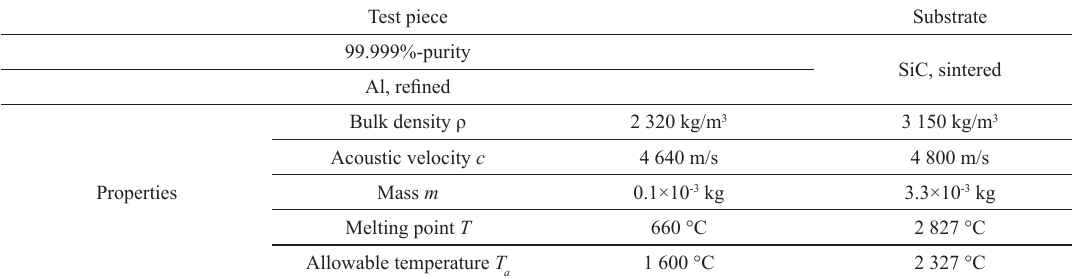
Table 1. Features of the metal and substrate samples.